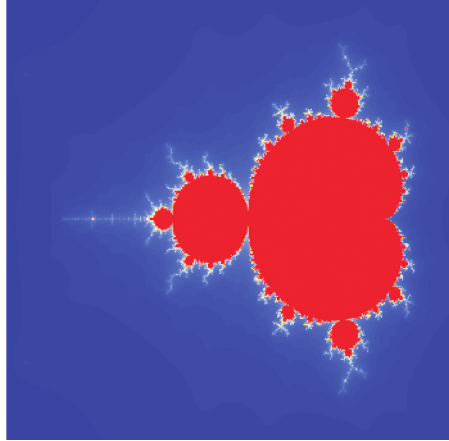
Figure 15: Quadratic Mandelbrot set in JSOmhh.